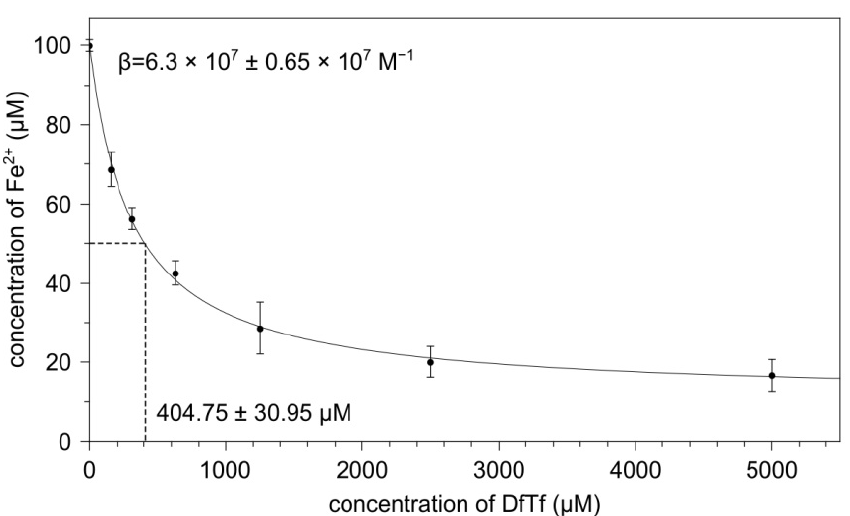
Figure 4. Effect of a conjugate of taxifolin with glyoxylic acid (DfTf) on the formation of the ferrozine-iron (II) complex.